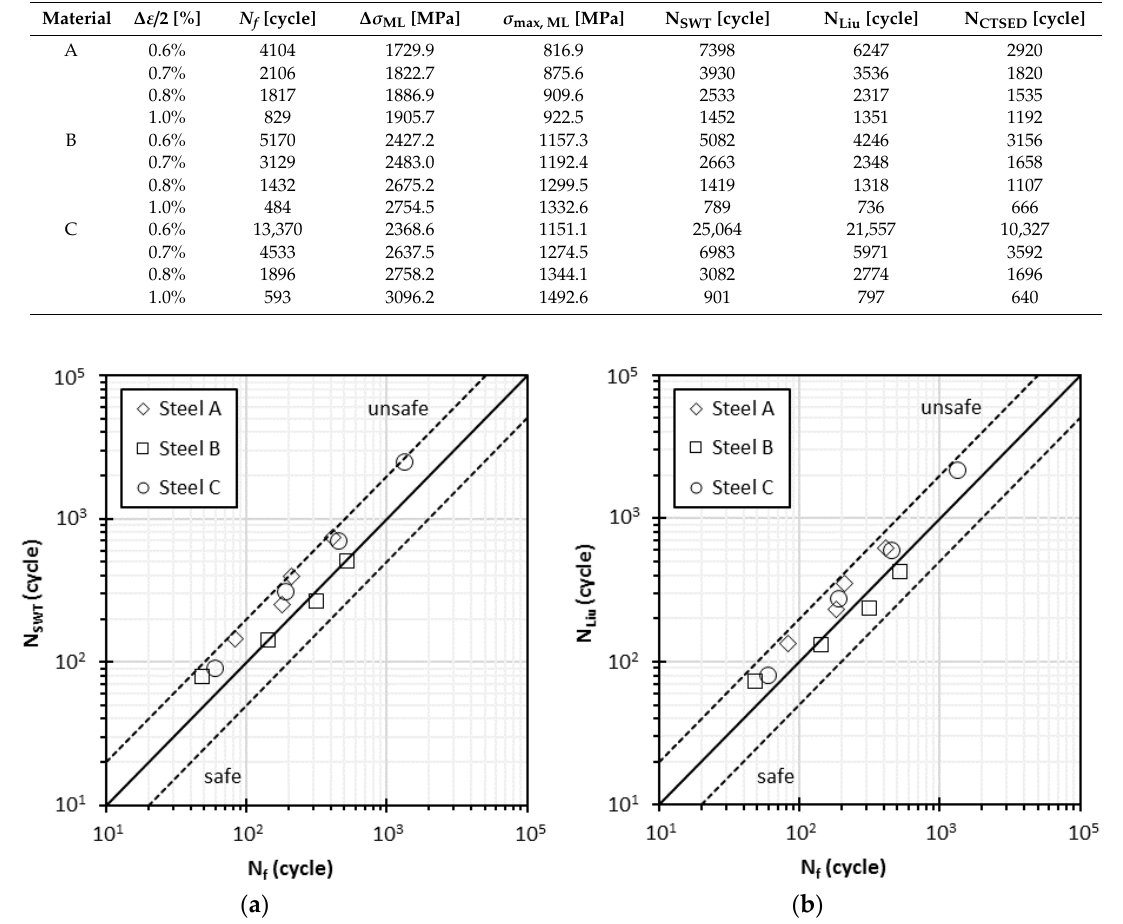
Figure 7. Comparison between numerical and experimental fatigue lives: ( a ) SWT criterion; and ( b ) Liu criterion.